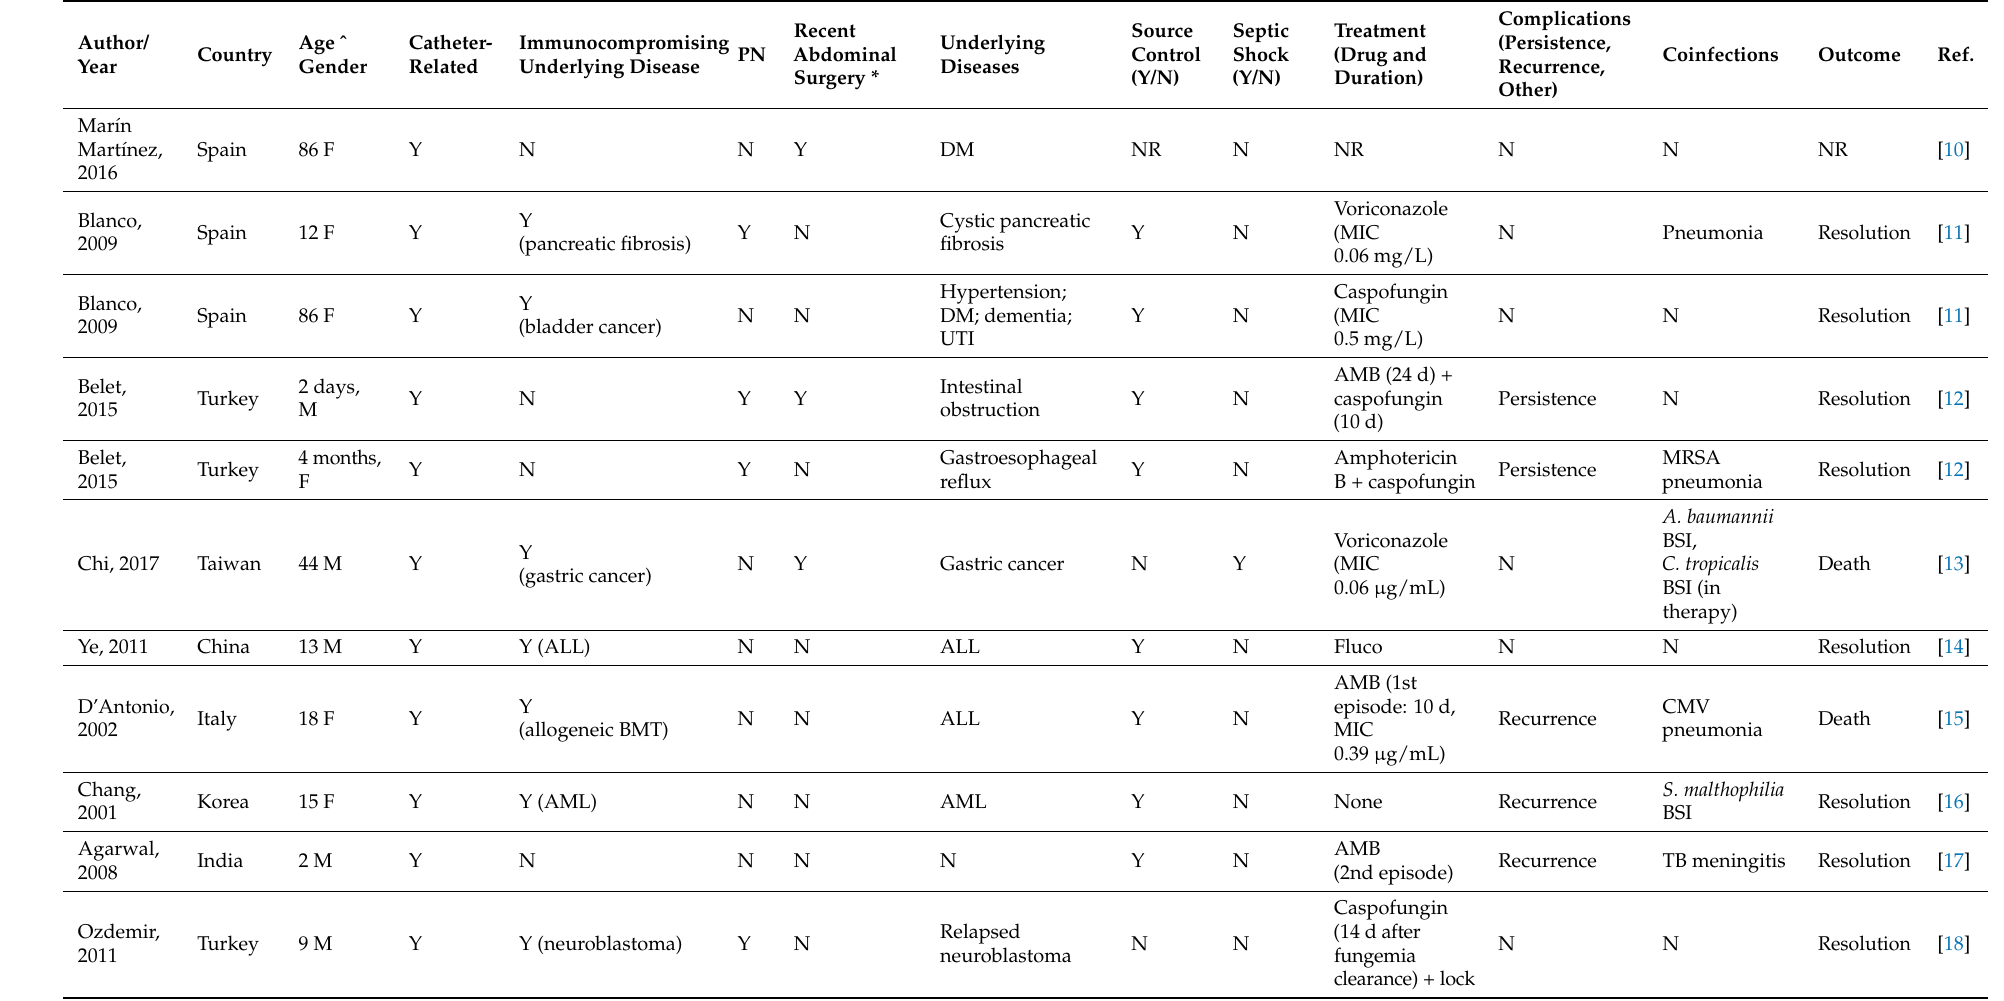
Table 1. Cases of C. lipolytica